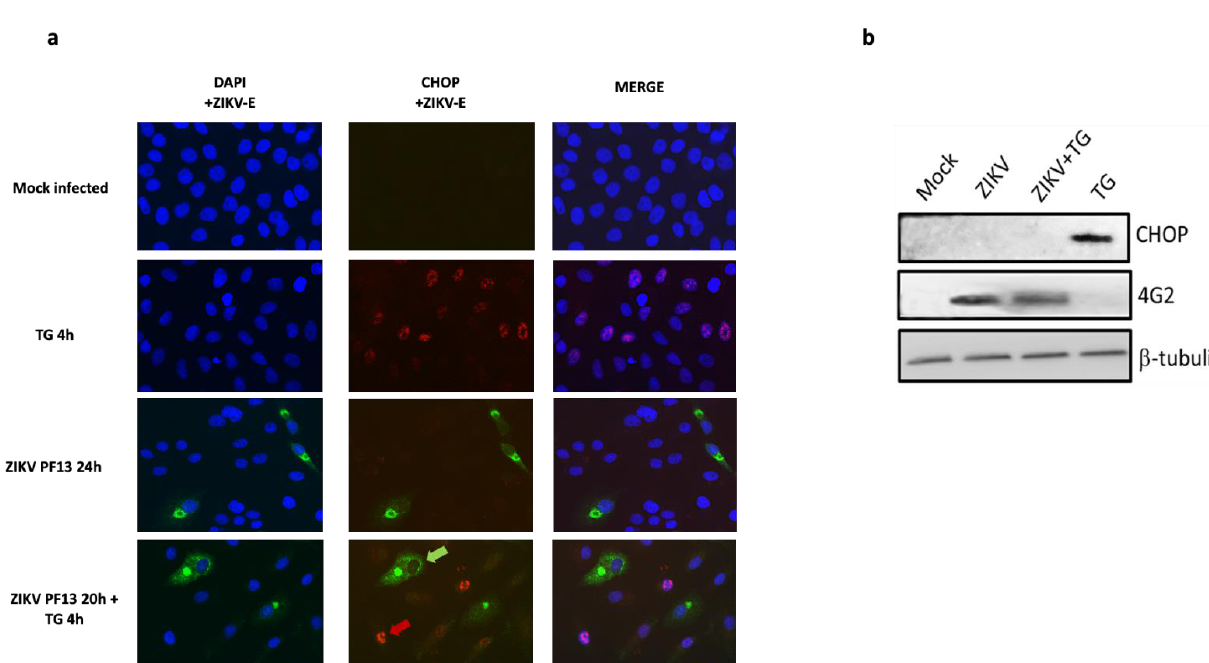
Figure 4. ZIKV inhibits CHOP protein expression in the infected cells. ( a ) Immunofluorescence detection of ZIKV envelope (ZIKV-E, green) expressing cells and CHOP protein (red) in A549 cells infected or not with ZIKV at MOI = 5 for 24 h, further treated or not with TG for 4 h at 20 h.p.i and cells treated with TG for 4 h. Nuclei were stained with DAPI (blue). h.p.i: hours post-infection. In the microscopic field of cells infected with ZIKV and treated with TG for 4 h at 20 h.p.i, the green arrow points a cell stained for ZIKV-E without CHOP staining in the nucleus and the red arrow points a cell which is not stained for ZIKV-E but has a CHOP stain in the nucleus. ( b ) A549 cells were infected or not with ZIKV at MOI 5 for 24 h, treated 20 h.p.i with TG for 4 h or only treated with TG for 4 h. The cells were harvested at the different conditions indicated above and subjected to western blot analysis using antibodies against CHOP and ZIKV envelope protein (4 G2). β-Tubulin was used as a loading control.